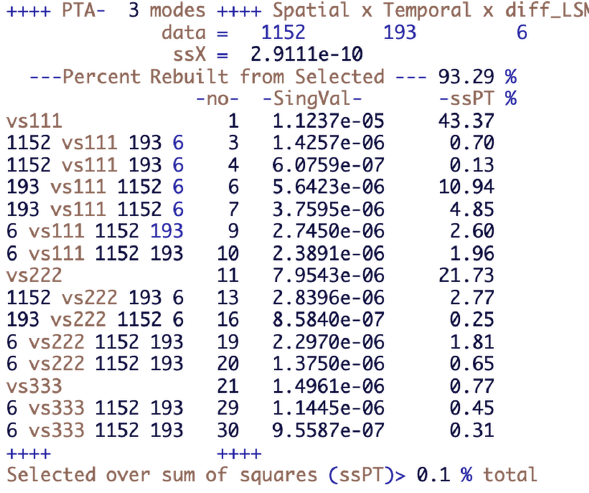
Figure 8. Summary of the PTA3 decomposition for the data table of the six normalized LSM